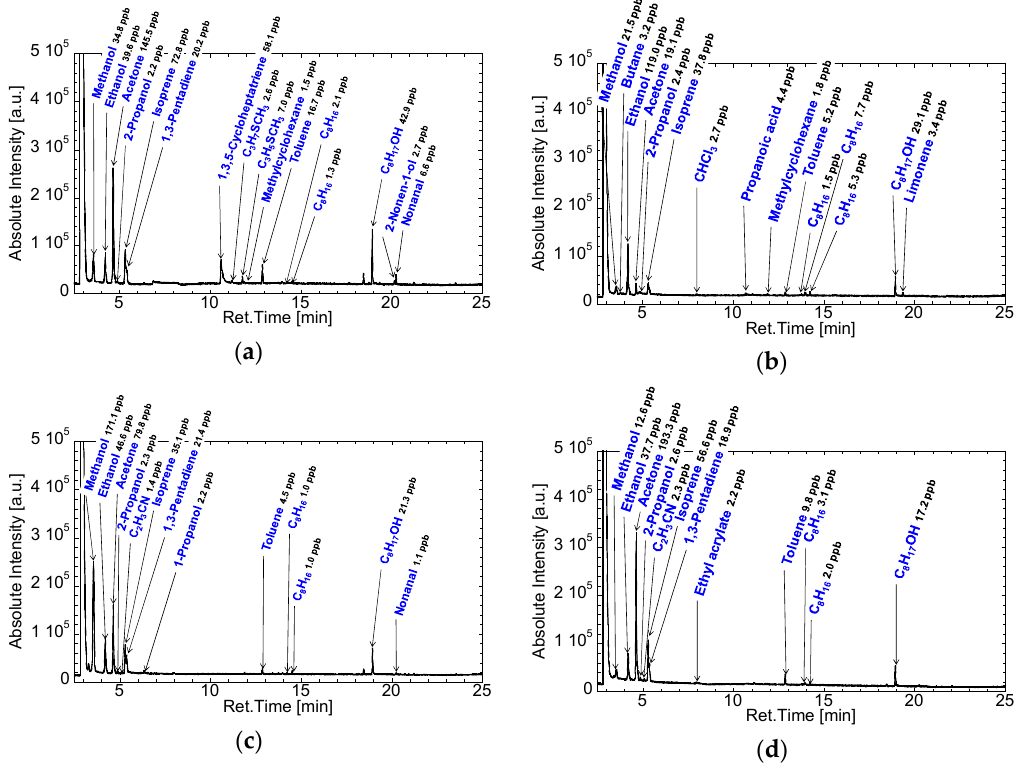
( b ) Figure 4. GC/MS spectra of the air of the consultation room in Aichi Cancer Center obtained using: an Analytic Barrier bag ( a ); and cleaned Tedlar bag ( b ). 3.2. Gas Condenser-GC / MS Analysis of Exhaled Breaths for Development of the GC-Gas Sensor-Gas Condenser-Type Prototype Figure 5a,b shows the GC/MS spectra of exhaled breaths from patients with lung cancer. The histology of lung cancer samples indicated that these samples were adenocarcinomas. The stages of lung cancer were IA and IIIA; the sample shown in Figure 5b (stage IIIA) was from a patient with a more advanced stage of cancer than that shown in Figure 5a (stage IA). However, the VOCs detected from the patient in Figure 5a were not necessarily detected from the patient in Figure 5b. Fuchs et al. reported that nonanal is a biomarker of lung cancer [37]. The concentration of nonanal in the breath sample from the patient in Figure 5a was 6.6 ppb, which was higher than the concentrations in exhaled breath samples from healthy controls (Figure 5c). In contrast, nonanal was not detected in the exhaled breath from the patient with lung cancer presented in Figure 5b. The exhaled breath of the patient with lung cancer presented in Figure 5b included propanoic acid, and the exhaled breath of the same patient after undergoing surgery did not include propanoic acid (Figure 5d). Moreover, propanoic acid was also not found in the exhaled breath of the patient with lung cancer presented in Figure 5a. In the gas condenser-GC/MS analysis, 56 VOCs were detected and identified from 136 exhaled breath samples, as presented in Table 2. Their average concentrations and standard deviations are also included in Table 2. These results may also imply that a particular VOC is actually not a suitable biomarker for lung cancer. In this study, we also found that the exhaled breath from patients with